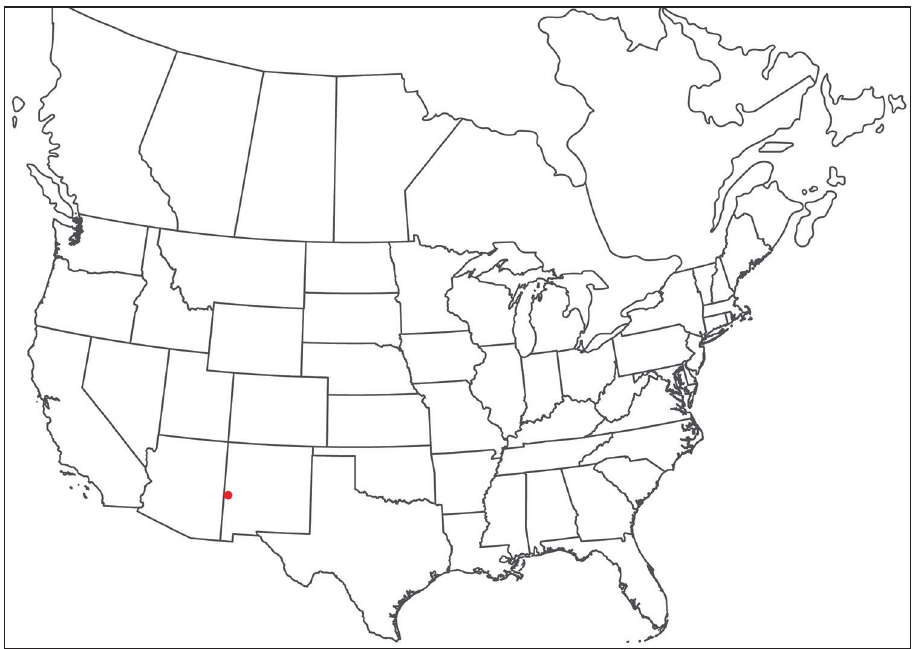
Figure 140. Torrenticola manni sp. n.